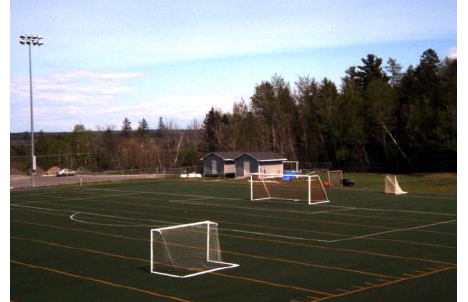
Figure 5: Scene 2 of the study areas